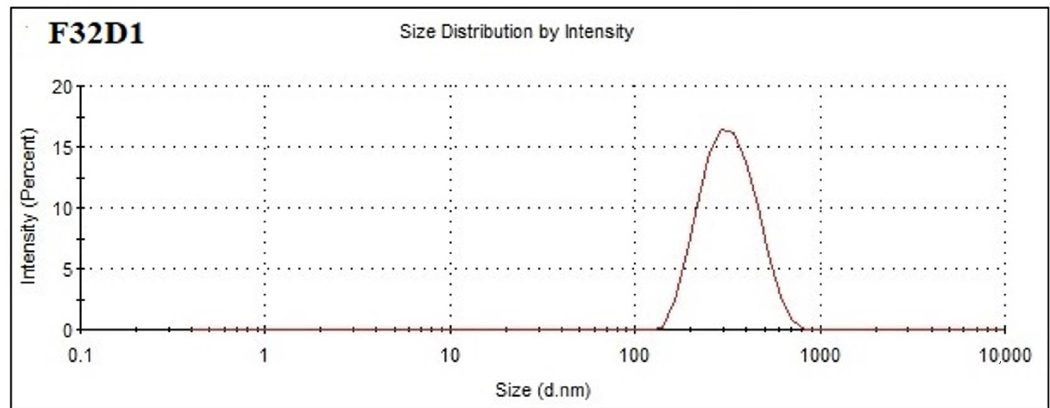
Figure 1. Particle size and polydispersity index (PDI) of MDZ-loaded chitosan nanoparticles (CS NPs) containing 1 mg / mL CS and 1 mg / mL sodium tripolyphosphate (Na-TPP) with drug:polymer ratio 1:1 (formulation F32 D1).